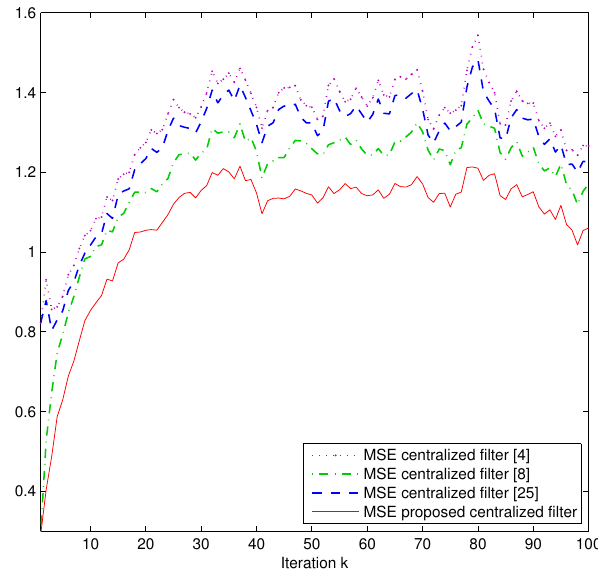
Figure 4. Filtering mean square errors when θ = 0.5 and γ ( i ) =